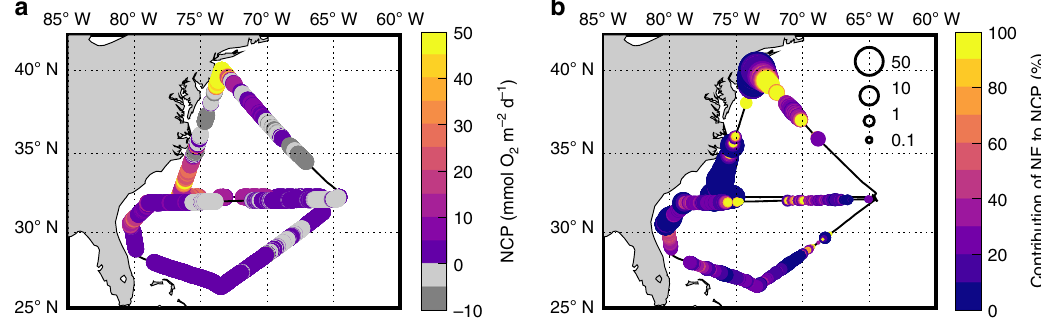
Fig. 3 Distribution of Net Community Production (NCP) and contribution of N 2 fi xation to NCP. a Color-coded NCP with negative values shown in grey color scale. b Distribution of the ratio of N 2 fi xation-supported carbon production to NCP. Circle size in b represents the magnitude of NCP, contextualizing the large uncertainty in calculated ratios when the denominator (i.e., NCP) is